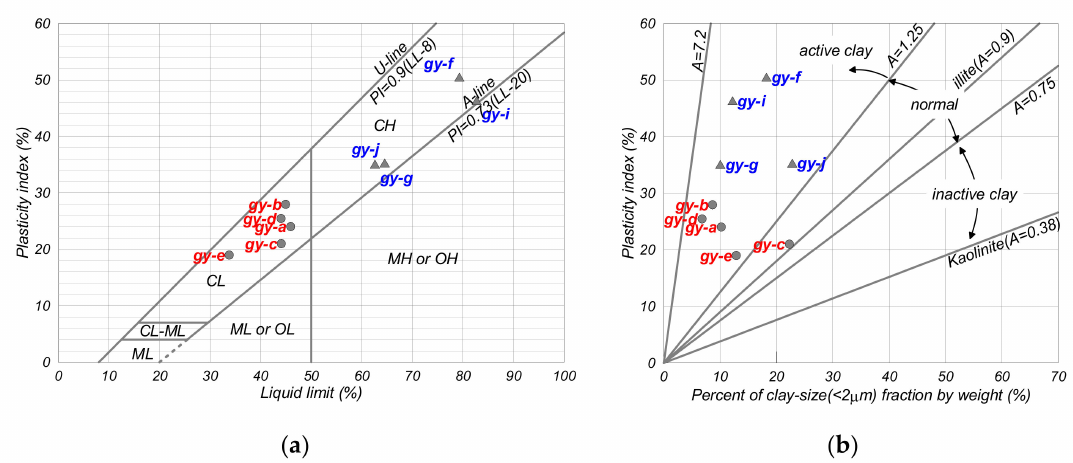
Figure 4. Physical properties of Gwangyang region soil: ( a ) Plasticity chart; ( b ) Activity chart.